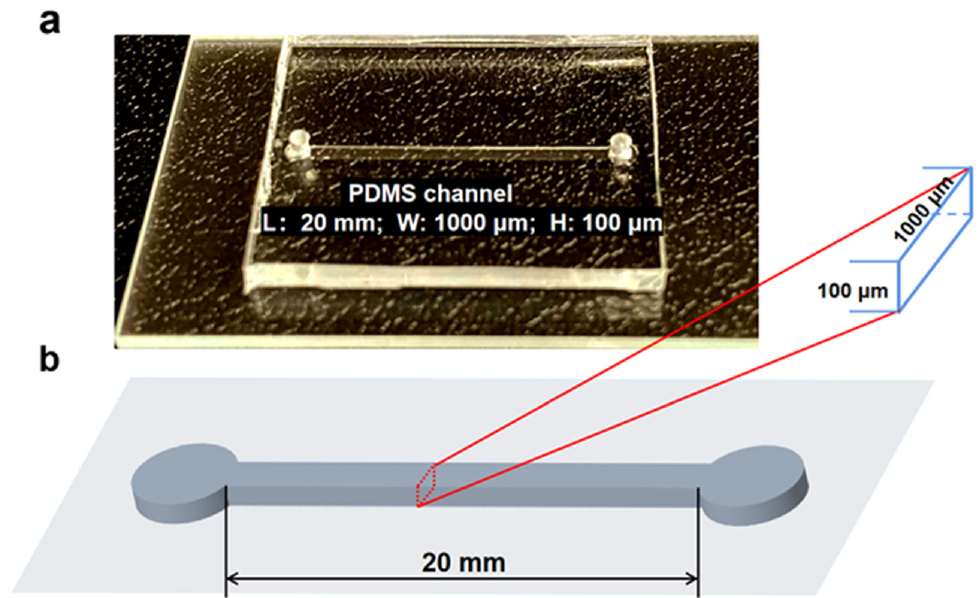
Figure 2. ( a ) PDMS microchannel 100 µ m high and 1000 µ m wide, with inlet and outlet ports. ( b ) Schematic drawing of the microchannel used in the experiments detailing the dimensions.